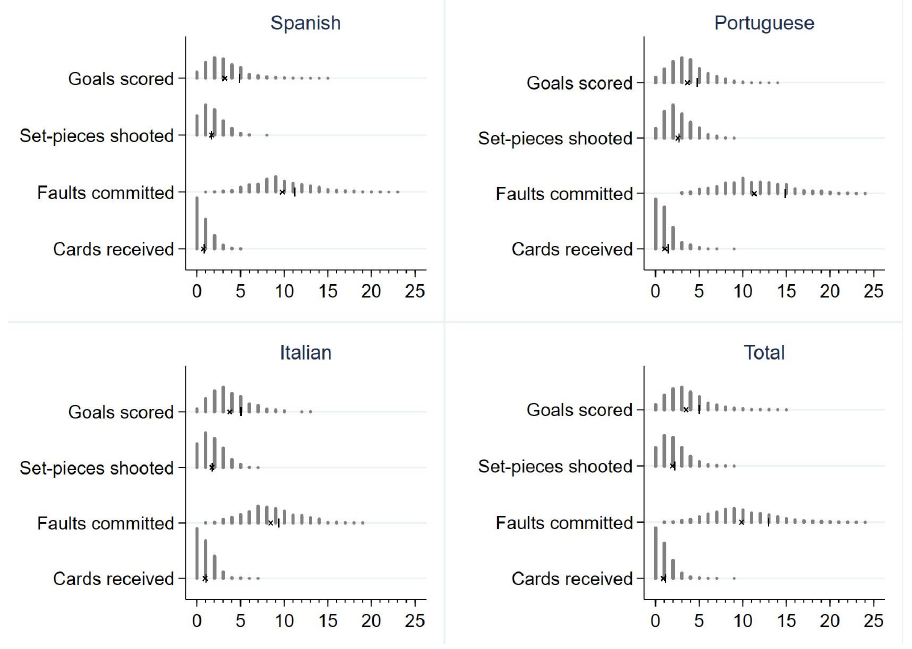
Figure 1. Distribution of the count-dependent variables.